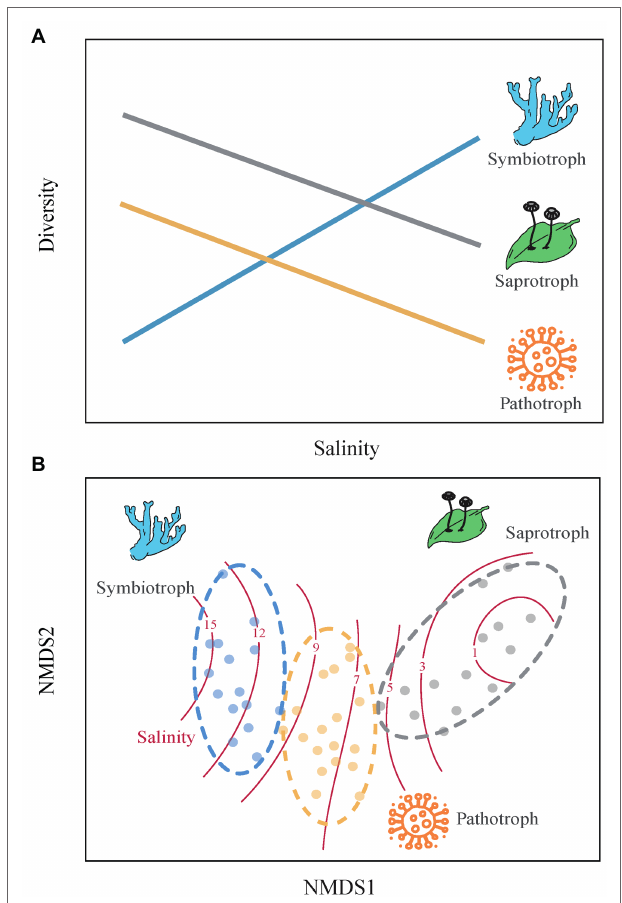
FIGURE 1 | The conceptual framework outlines changes in community structure of three functional guilds of soil fungi along a soil salinity gradient. (A) Alpha diversity. We expect that the alpha-diversity of symbiotrophic fungi would increase with soil salinity because symbiotrophic fungi depend highly on host plant at high-salinity sites (Ren et al., 2016), while that of soil saprotrophic and pathotrophic fungi would decrease with soil salinity because high salinity can hinder the activity of soil fungi that mainly use soil organic matter (Rath et al., 2016). (B) Community composition. Since soil symbiotrophic, sapraotrophic, and pathotrophic fungi have different niches (Frac et al., 2018), we therefore expect that symbiotrophic fungi occur at higher salinity levels, then do pathotrophic and sapraotrophic